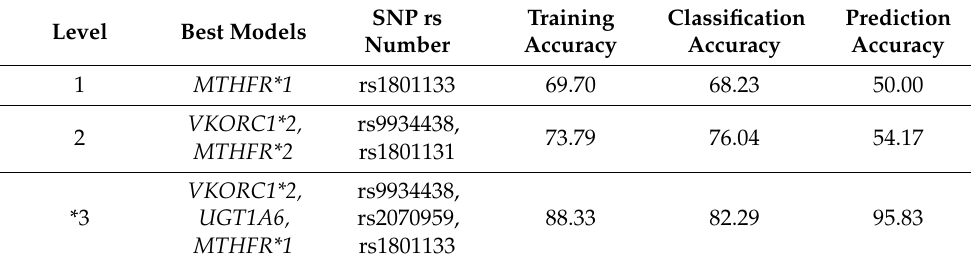
Table 7. Summary table for MDR fit with three-way split validation (k = 3).